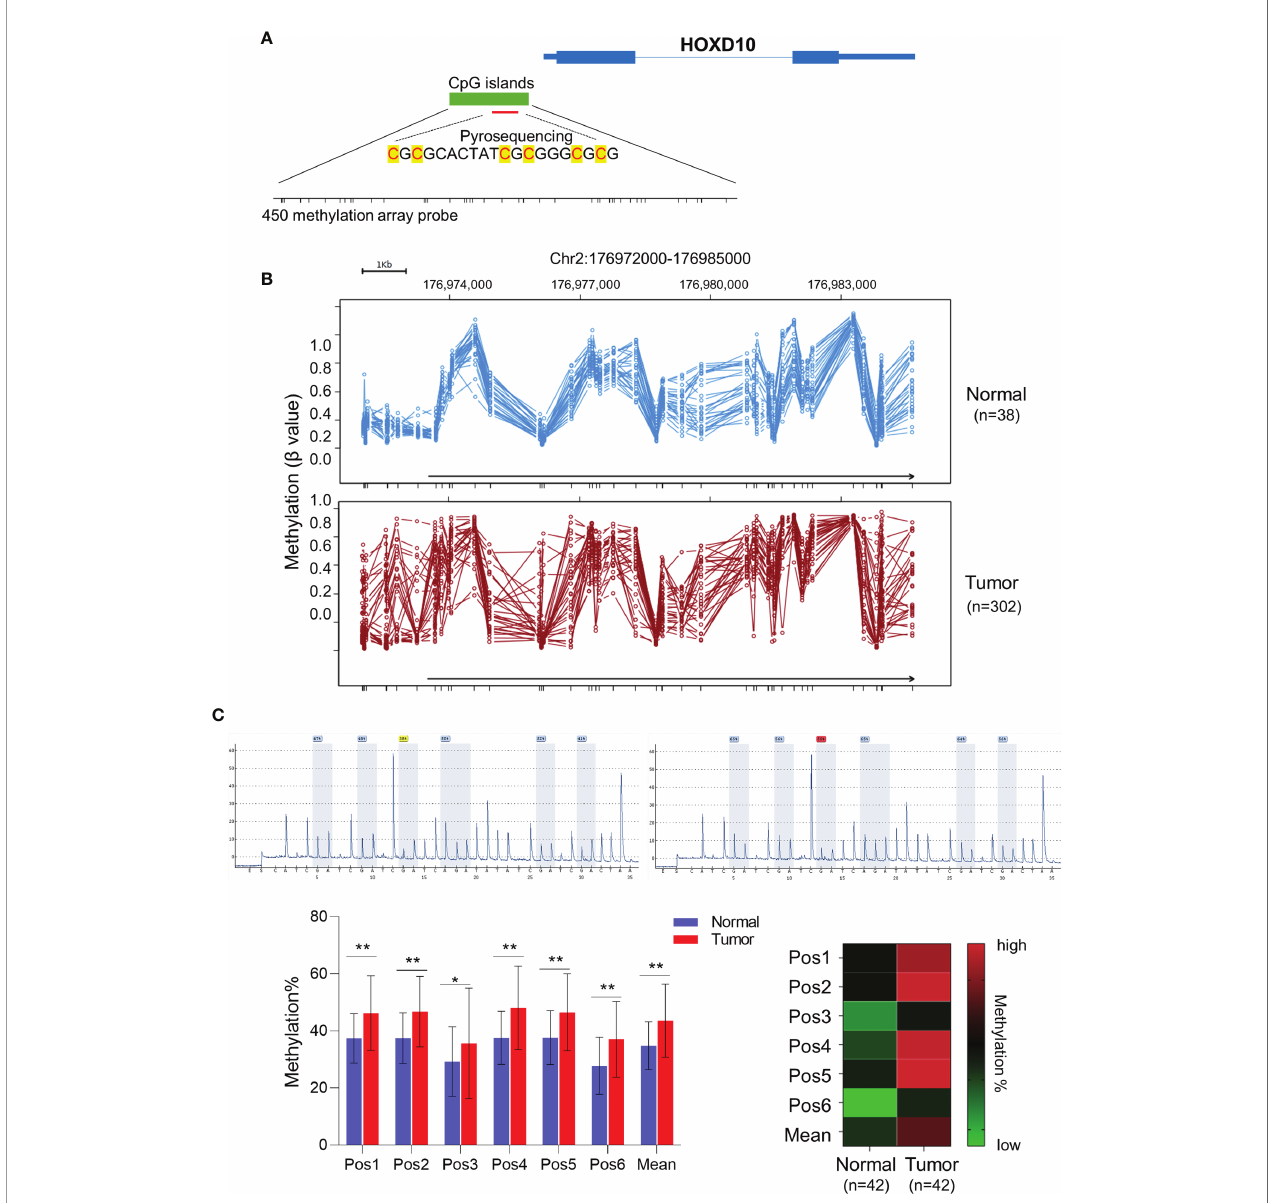
FIGURE 1 | HOXD10 is frequently methylated in colorectal cancer. (A) Illustration of the CpG sites for pyrosequencing and HumanMethylation450 BeadChip loci in the promoter region of HOXD10 . (B) The web tool Wanderer showed the methylation value of each 450 methylation loci in normal and colorectal cancer tissues. (C) Representative images of the pyrosequencing data are shown on the top left (#1 normal tissue) and top right (#1 cancer tissue). The bottom left image shows the methylation value of six CpG sites from 42 cancer tissues and normal tissues. * p < 0.05, ** p < 0.01 (Mann – Whitney test). The bottom right image shows the heatmap of the methylation value from the six CpG